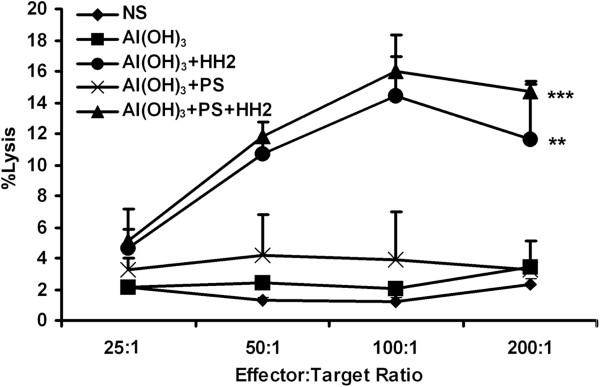
NAPH vaccine stimulates the innate immune response. 48 hours after NAPH injection, the mice were sacrificed. A standard 4 h NK assay against YAC-1 targets revealed that the NK cytotoxicity in the NAH group was higher than that in the NS, NA and NAP groups; in particular, NAPH-treated mice had the greatest cytotoxic activity against YAC-1 cells among all groups (* P < 0.05; ** P < 0.005).